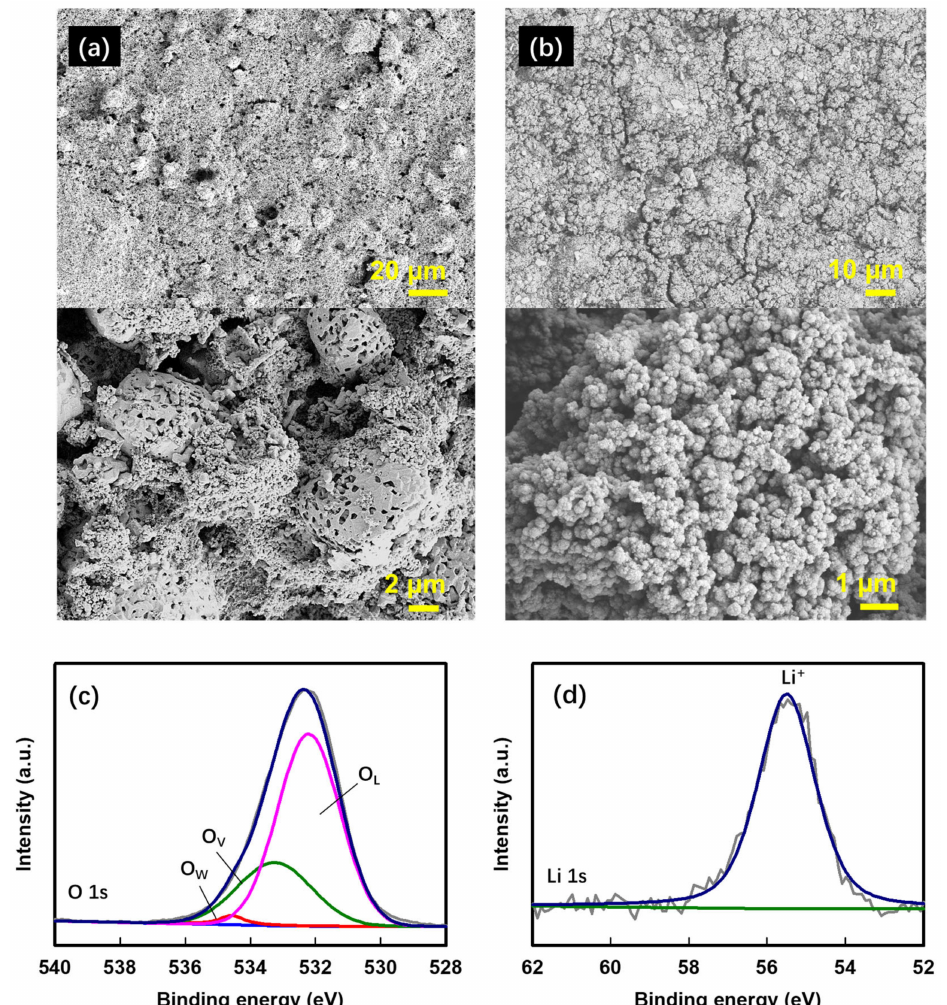
Figure 10. FE-SEM images of the proposed HEMO3 anodes. Surface FE-SEM images of the proposed HEMO3 anodes ( a ) before the cycles, and ( b ) after 100 cycles, and the high-resolution XPS spectra of ( c ) O 1s and ( d ) Li 1s energy regions for HEMO3 anodes after 100